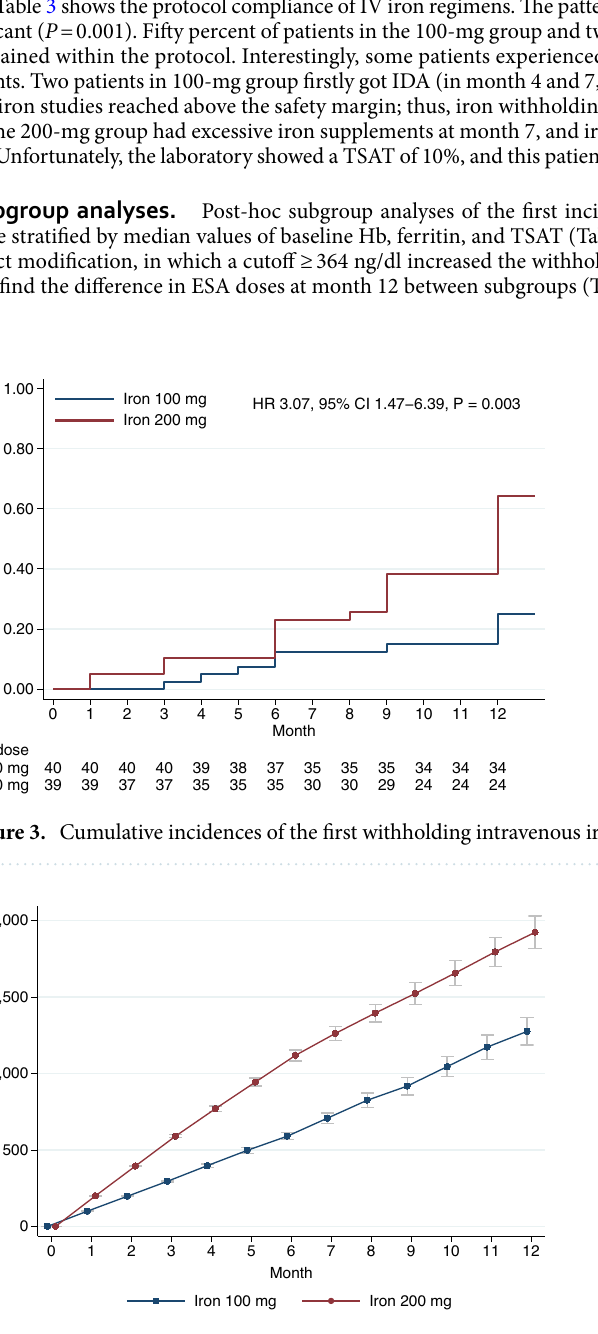
Figure 4. The mean cumulative doses of intravenous iron. The bars indicate 95% confidence intervals. The cumulative doses in each month were compared with the linear random-intercepted model. After month 2, patients in 200-mg intravenous iron group received higher cumulative iron doses than 100-mg group with statistical significance ( P <